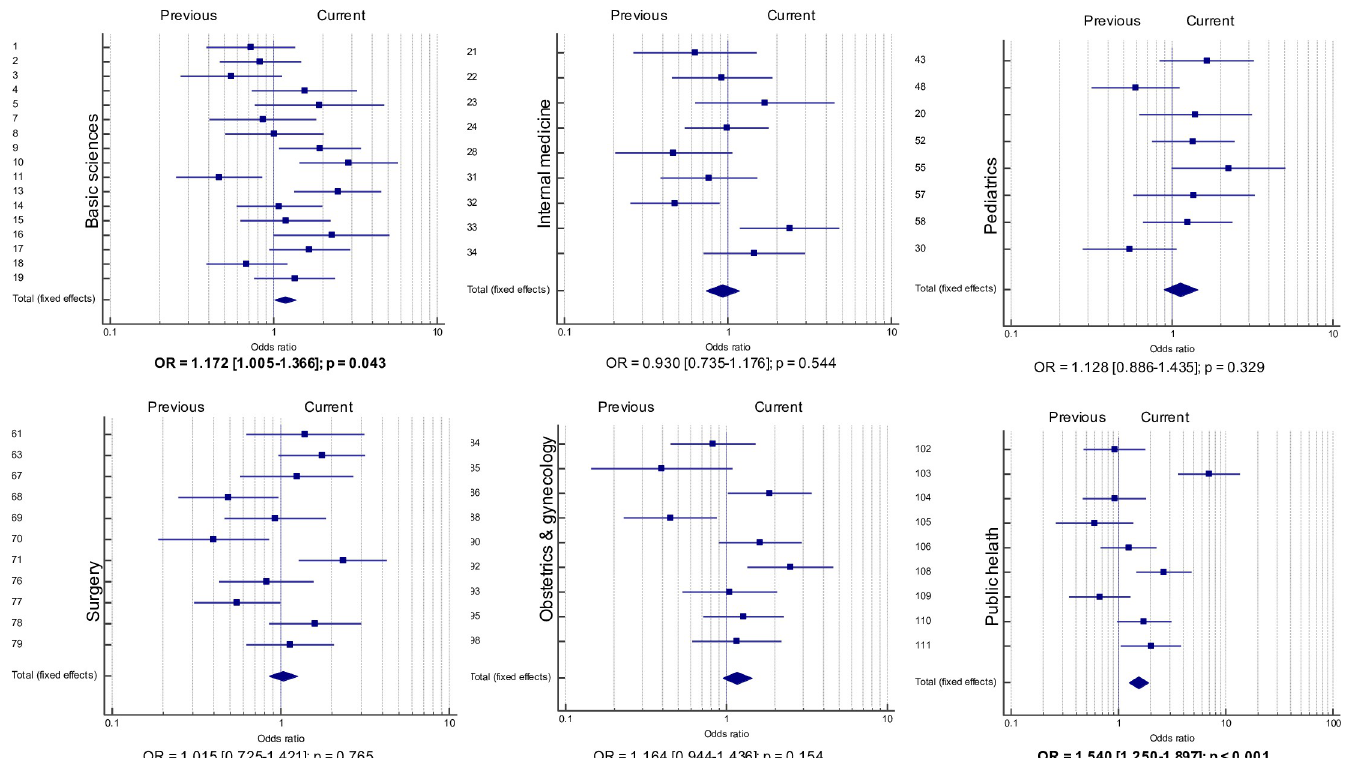
Fig 1. Forest plots of the pooled analysis according to the exam’s different content areas. The vertical axis represents the item number on the 2019 exam. Each point represents the OR with its respective CI (horizontal bars). When points appear on the left of the vertical line identified as “1”, it indicates that students exposed to the old curriculum performed better, whereas points on the right indicate better performance for students with the new curriculum. Significant differences were found in basic sciences and public health.